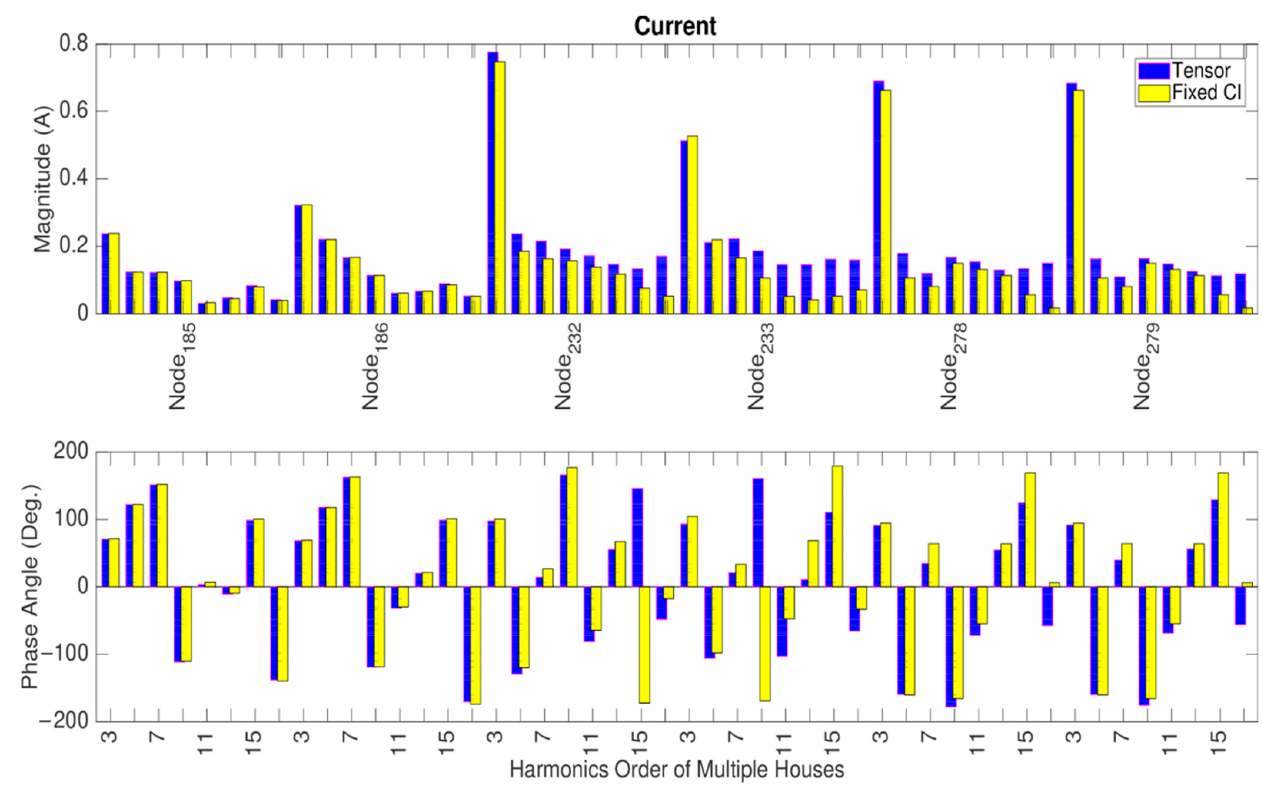
Figure 8. Urban LV network (30%).